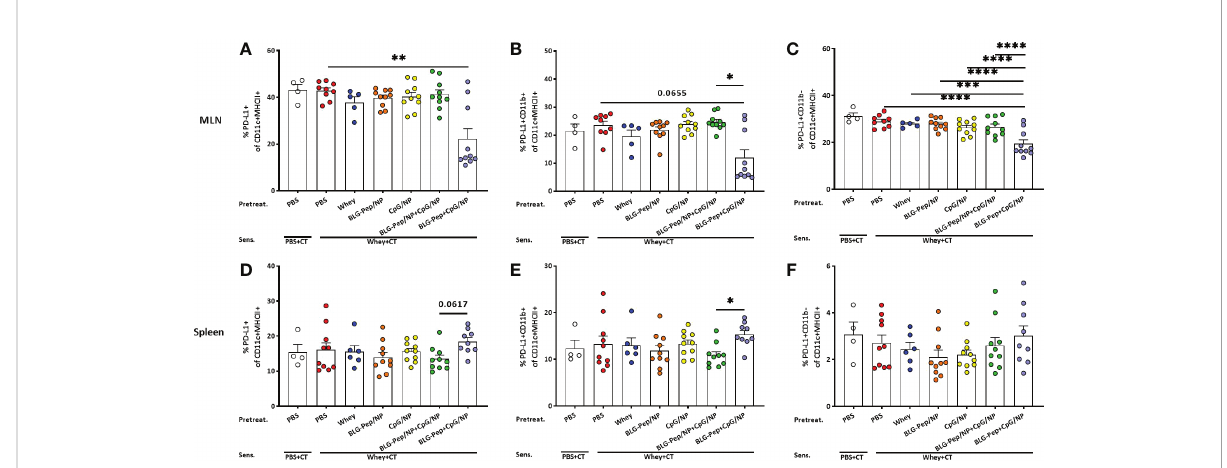
FIGURE 4 Expression of PD-L1 on dendritic cells from mesenteric lymph nodes (MLN) and spleen. Eighteen hours after the last oral challenge with whey, cells isolated from MLN and spleen were analyzed by fl ow cytometry for the frequencies of PD-L1+ on CD11c+MHCII+ DC (A, D) , PD-L1 +CD11b+ (B, E) and PD-L1+CD11b- (C, F) DC subsets in MLN and spleen respectively. Data are presented as mean ± SEM for n=8-10 per group except for the sham group, n=4 and whey-tolerant group, n=6. (A, B) and (D – F) are analyzed with the Kruskal-Wallis non-parametric test, followed by Dunn ’ s post hoc test for selected pairs; (C) is analyzed with one-way ANOVA for selected pairs after log transformation, followed by Bonferroni ’ s post hoc test; * p <0.05, ** p <0.01; CT, Cholera toxin. ***p<0.001,